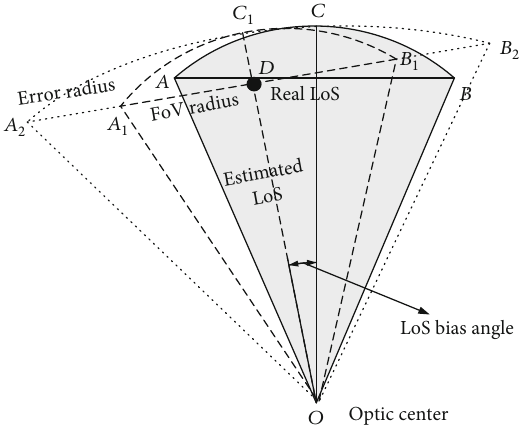
Figure 5: Inertial error analysis for the